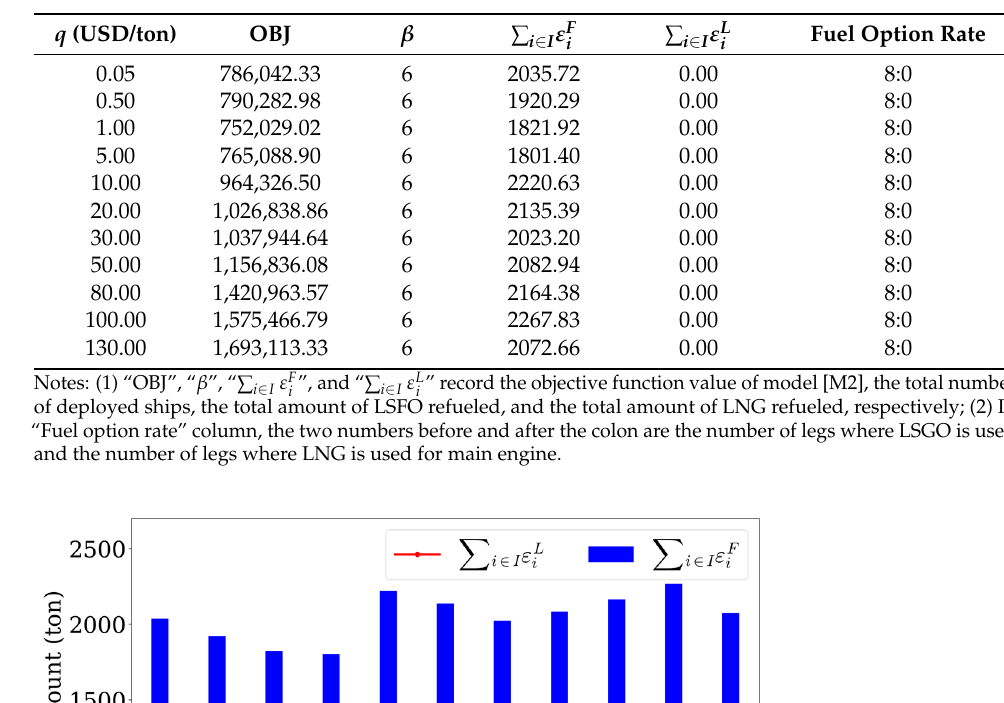
Table 4. Impact of carbon tax on the operation decisions.